Question: According to the figure, is the described quantity increasing or decreasing?
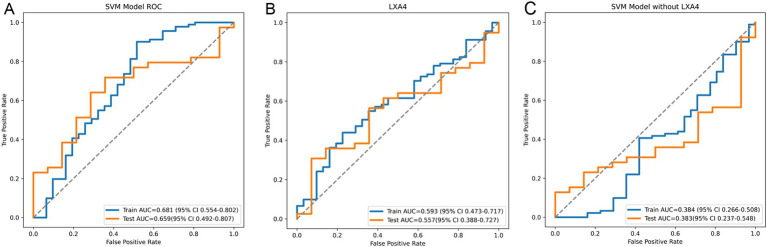
Answer: decreasing